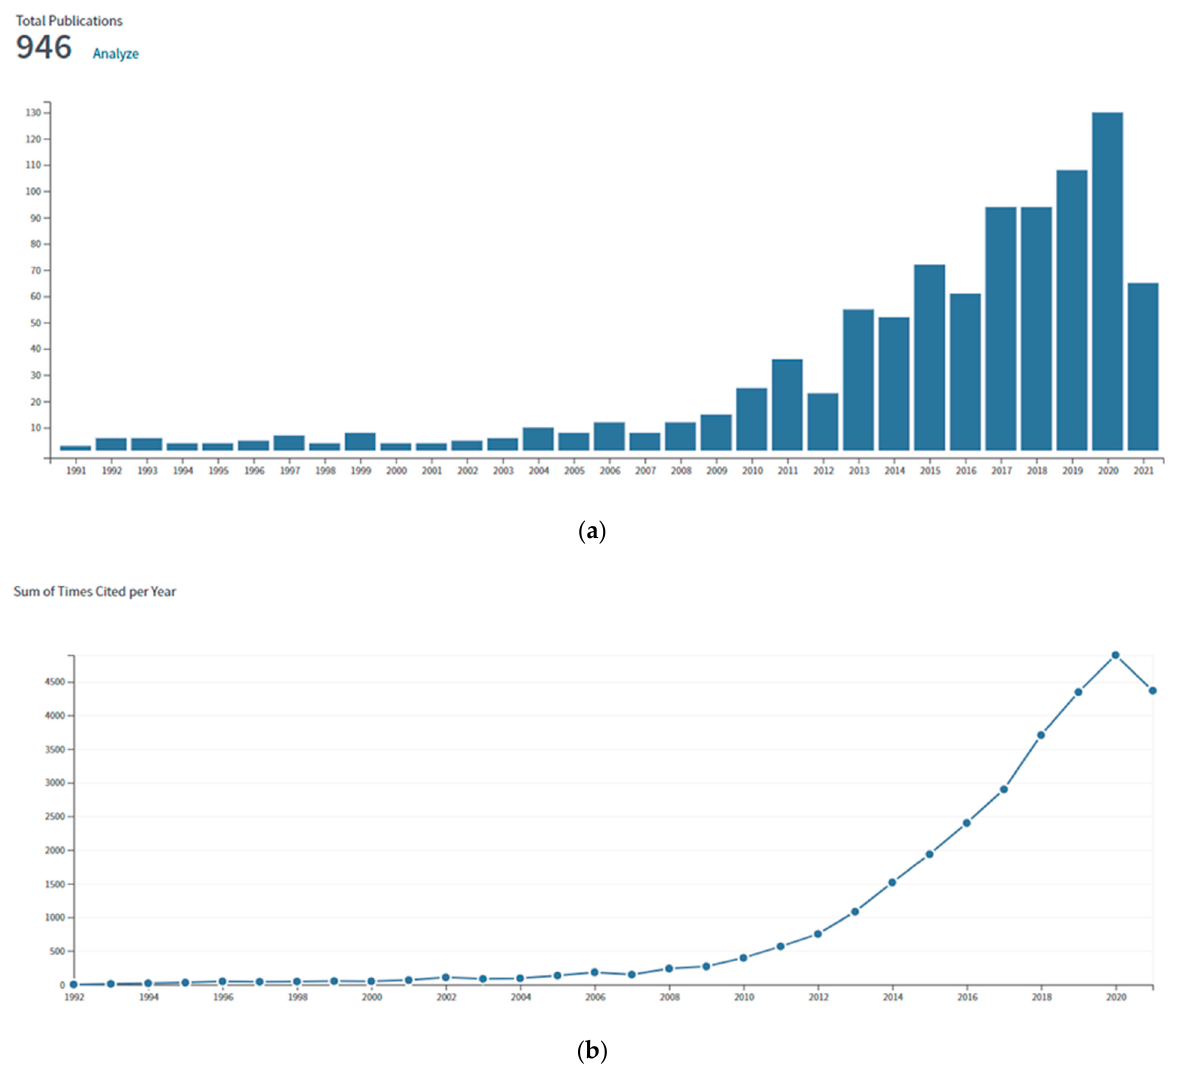
Figure 1. ( a ) Number of publications and ( b ) number of citations on the topic “composite anion exchange membranes” (from ISI Web of Science 2021).